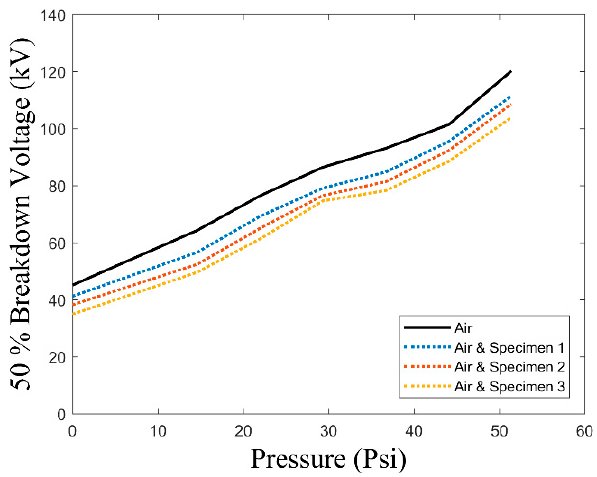
Figure 14. Lightning impulse discharge test results for negative polarity regarding air alone as well as in conjunction with open cell foam specimens of Table 4.